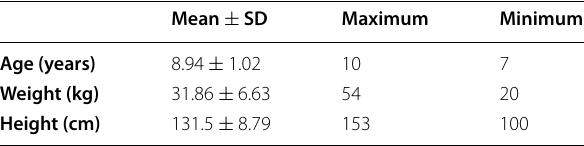
Table 1 Descriptive statistics for age, weight, and height of